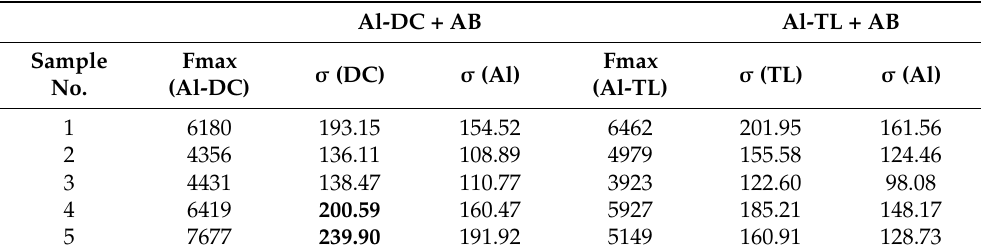
Table 9. Maximum load Fmax [N] and stress σ [MPa] in substrates used in welded-bonded joints (rubber-based adhesive).